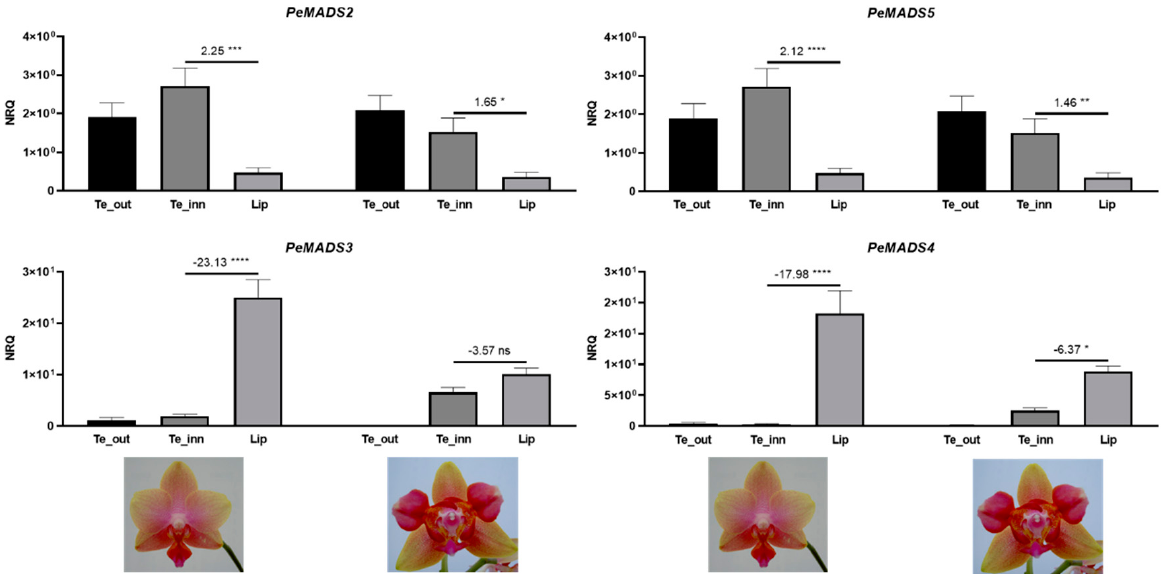
Figure 7. Relative expression of the class B MADS-box genes PeMADS2-PeMADS5 in the perianth of Phalaenopsis hyb. “Athens” wild-type (left) and peloric mutant (right) at the B2 developmental stage (bud size 1–1.5 cm). The expression is reported as normalized relative quantity (NRQ). The vertical bars represent the SEM of the biological and technical replicates. The numbers above the horizontal lines are the mean differences of the expression between lateral inner tepals and labellum (Te_inn-Lip). p -Values * <0.05, ** <0.01, *** <0.001, **** <0.0001; ns, not significant. Te_out, outer tepals; Te_inn, lateral inner tepals or labellum-like structures that substitute the lateral inner tepals in the peloric mutant.